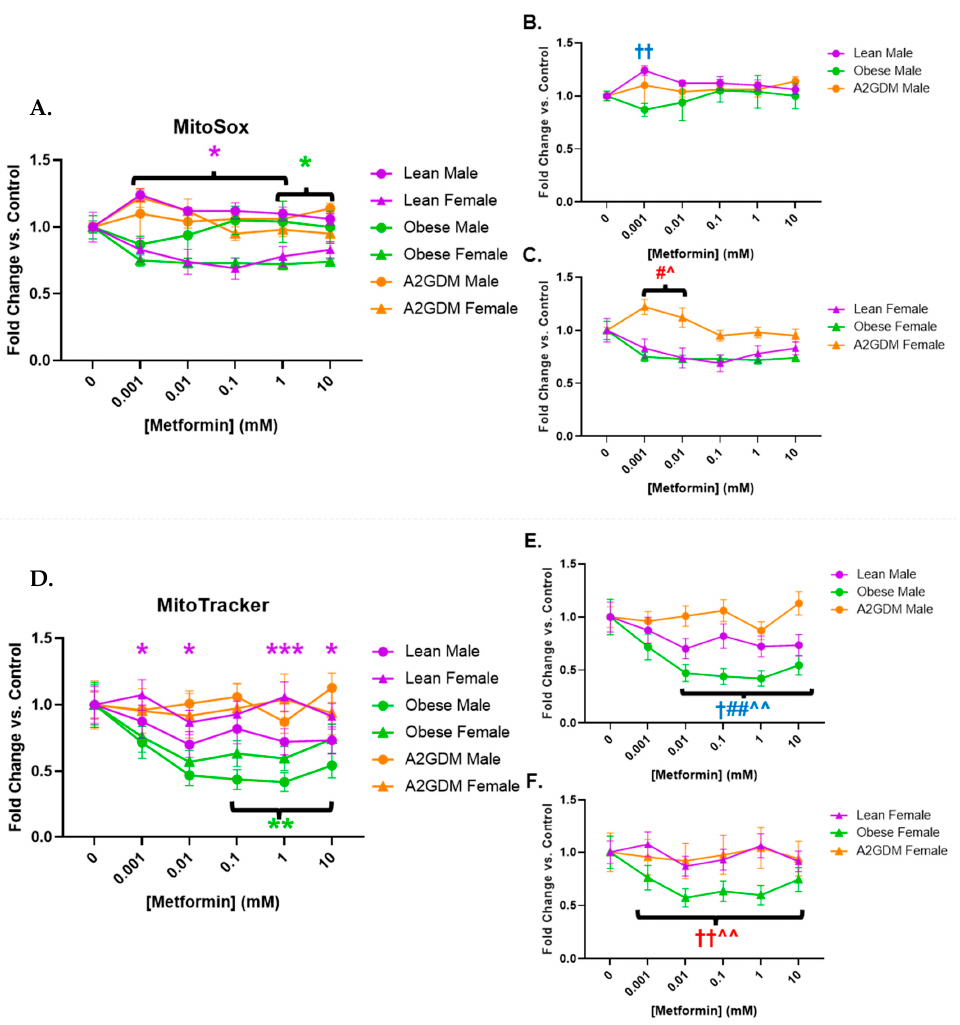
Figure 5. Changes in mitochondrial superoxide production and active mitochondria in response to metformin. ( A ) MitoSox Red measurement of superoxide production with all groups combined, ( B ) males only, and ( C ) females only. ( D ) Mitochondrial activity quantification measured by fluo- rescence using MitoTracker with all groups combined, ( E ) males only, and ( F ) females only. Values, normalized to no treatment controls, expressed as means ± SD. Statistical assessment was performed using 2-way ANOVA with Tukey post hoc. Difference at indicated metformin concentrations: Be- tween sexes within group: Lean *, Obese *, A2GDM * . Lean vs. Obese Males † and Females † . Lean vs. A2GDM Males # and Females # . Obese vs. A2GDM Males ˆ and Females ˆ